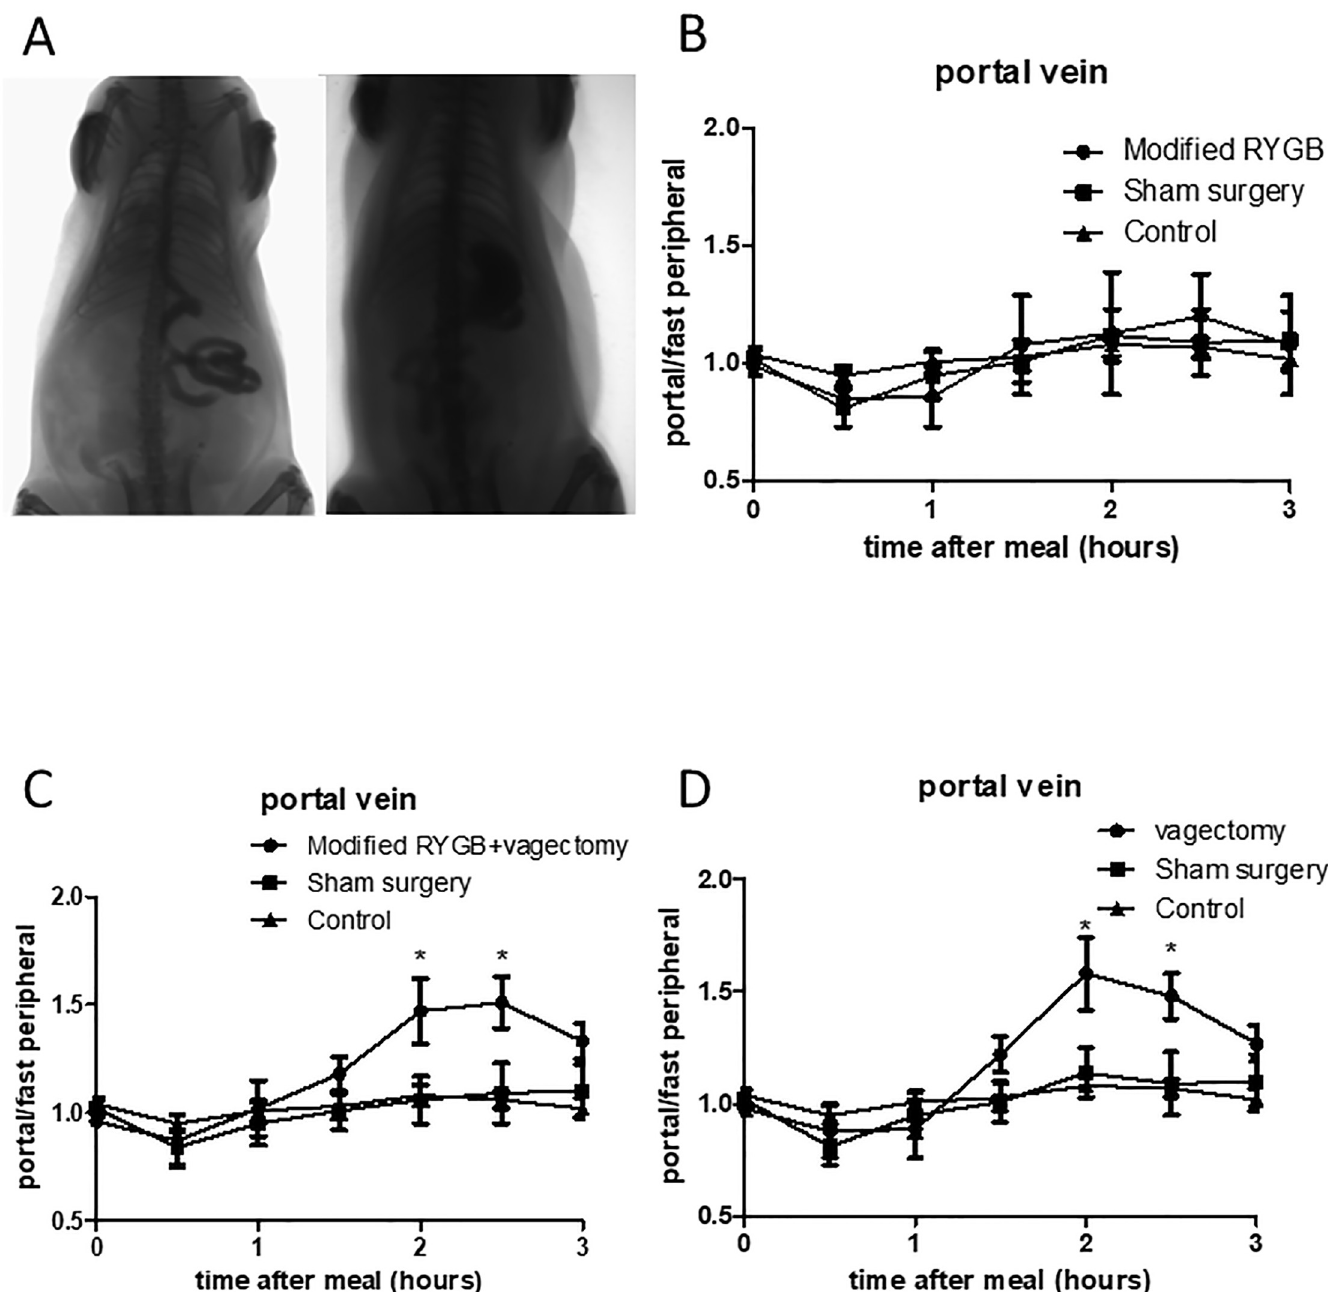
Fig 2. Roles of the gastric vagus during RYGB. A. Schematic diagram of iodine hydrography of RYGB with stomach preserved. Picture shows iodine water passing through the stomach into the duodenum. Classic RYGB was shown in the left while the vagus preserved RYGB (modified RYGB) was shown in the right. B. Changes of nesfatin-1 concentration in portal vein blood before (detecting nesfatin-1 concentration in peripheral vein blood) and after meal in rats undergoing RYGB with vagus preserved (modified RYGB) (n = 10 in each group, p > 0.05 in all time points, one way ANOVA). C. Changes of nesfatin-1 concentration in portal vein blood before and after meal of rats undergoing modified RYGB plus vagectomy. ( � p = 0.021 for 0.5h, � p < 0.026 for 1h after meal, p < 0.001 in 2, 2.5, 3h time point, n = 10 in each group, one way ANOVA). D. Changes of nesfatin-1 concentration in portal vein blood before and after meal in rats undergoing vagectomy. ( � p < 0.023 for 0.5h, � p = 0.02 for 1.5h, � p < 0.001 for 2, 2.5 and 3h after meal, n = 10 in each group, one way ANOVA).